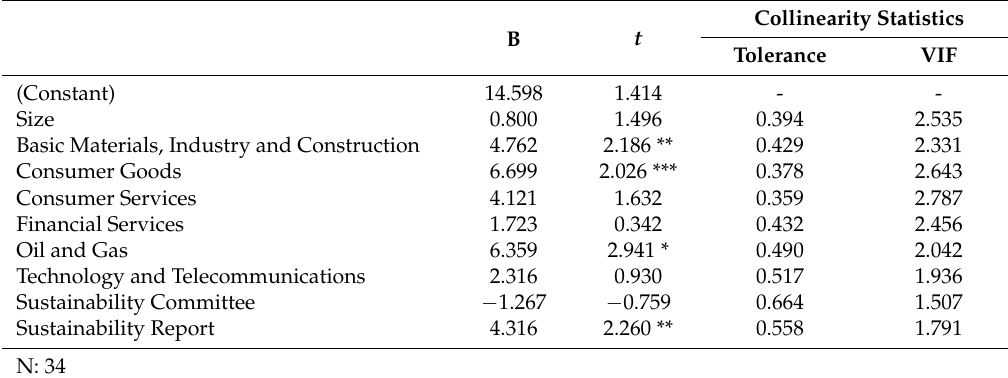
Table 12. Human Rights Matters Index as Dependent Variable.